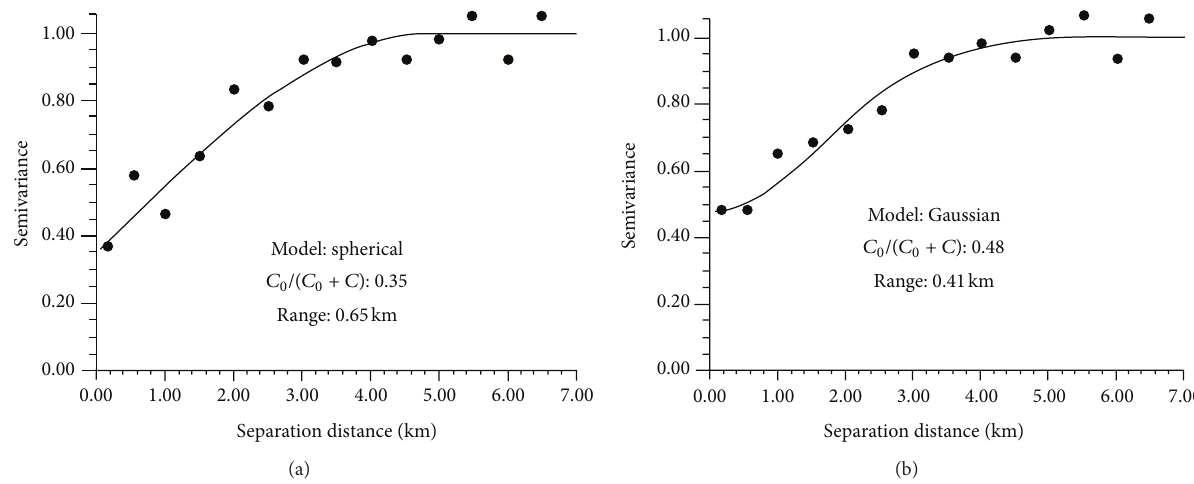
Figure 3: Experimental variograms of the normal score transformed data for soil Cd (a) and pH (b), with fitted models and parameters.